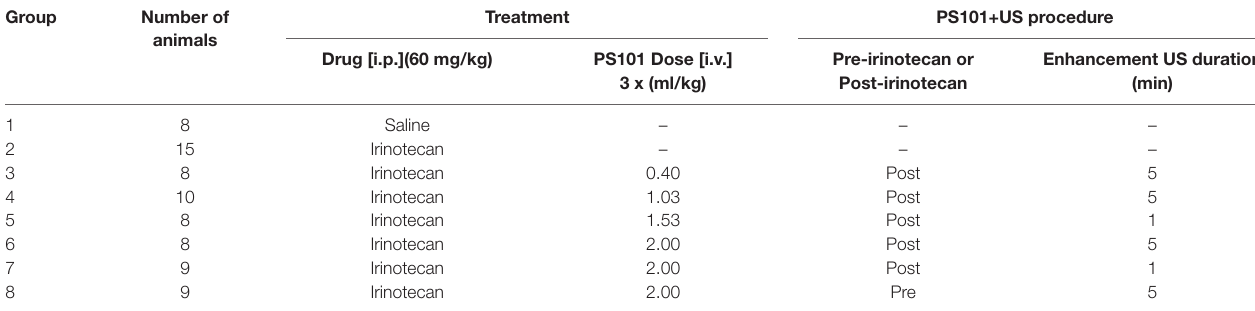
TABle 1 | Summary of the treatment groups; number of mice, PS101 dose, PS101+US/irinotecan order, and enhancement ultrasound duration. group number of animals